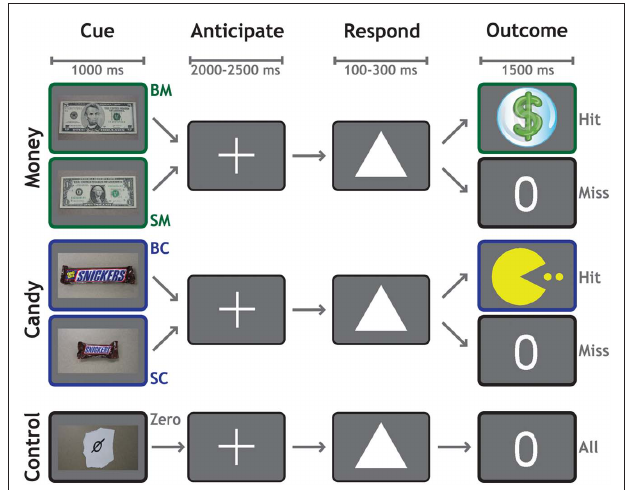
FIguRe 1 | Reward anticipation task. The reward anticipation task had five conditions according to potential outcome: $5 Cash (BM), $1 Cash (SM), Large Candy (BC), Small Candy (SC), and Zero (no cash or candy). Each trial began with a 1000-ms cue indicating the potential reward for that trial. Following a variable delay of 2000–2500 ms, a target appeared on the screen. The participant’s task was to respond by pressing a button with their right index finger, before the target disappeared. Successful trials were indicated by a dollar sign (cash trials) or a cartoon (candy trials), whereas unsuccessful trials were indicated by a zero. Feedback for all trials was presented for